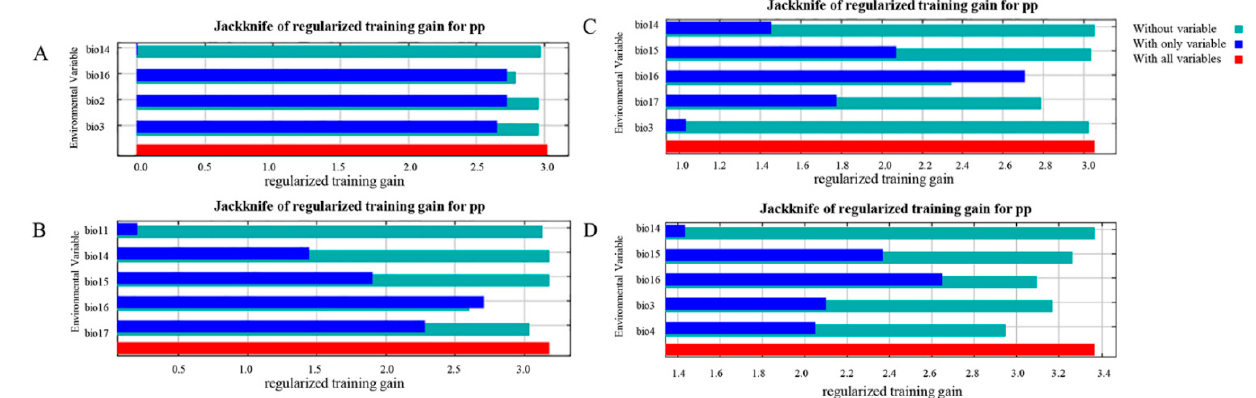
Figure 7. The jackknife method testing the importance of the influence of different climate models’ main environmental variables on suitable leopard distribution. ( A ). Jackknife test of environmental variables in modern situations. ( B ). Jackknife test of environmental variables under the future rcp2.6 climate model. ( C ). Jackknife test of environmental variables under the future rcp4.5 climate model. ( D ). Jackknife test of environmental variables under the future rcp8.5 climate model.